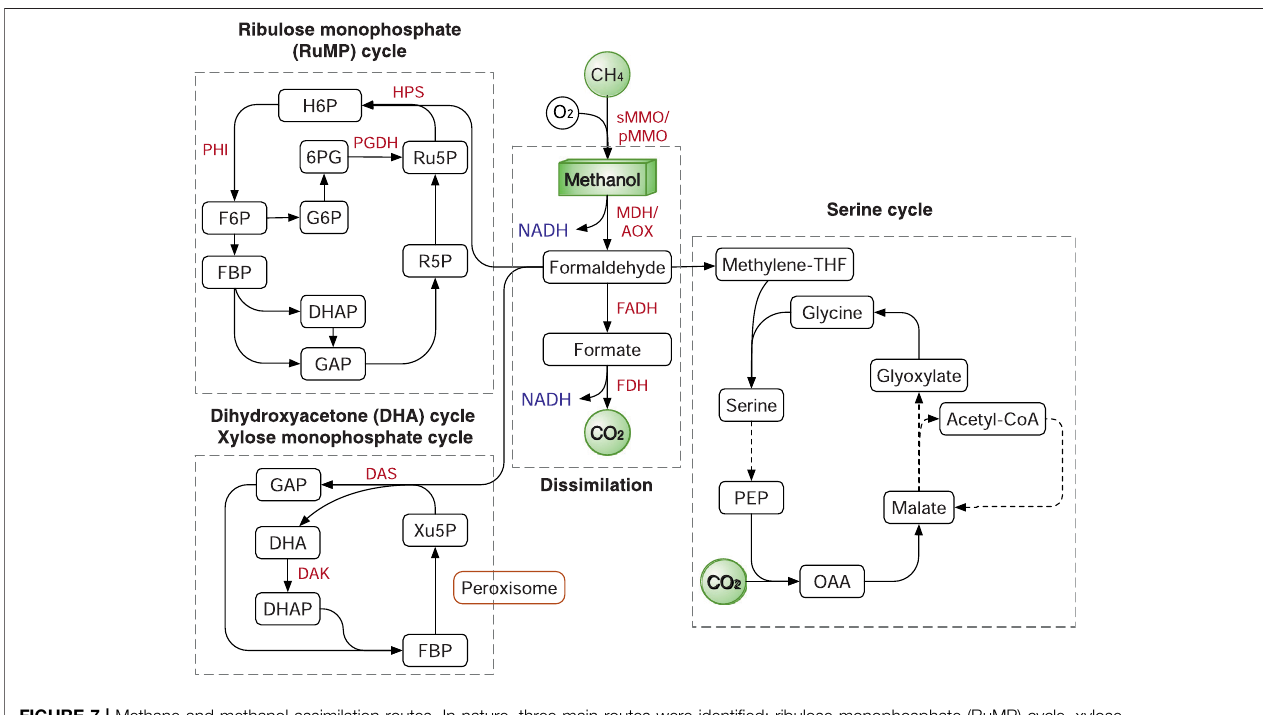
FIGURE 7 | Methane and methanol assimilation routes. In nature, three main routes were identi fi ed: ribulose monophosphate (RuMP) cycle, xylose monophosphate (XuMP) cycle or dihydroxyacetone (DHA) cycle and Serine cycle. Enzymes: HPS, 3-hexulose-6-phosphate synthase; PHI, 6-phosphate-3- hexuloisomerase; PGDH, 6-phosphogluconate dehydrogenase; MMO, methane monooxygenase; MDH, methanol dehydrogenase; AOX, alcohol oxidase; FADH, formaldehyde dehydrogenase; FDH, formate dehydrogenase. Metabolites: H6P, hexulose 6-phosphate; F6P, fructose-6-phosphate; FBP, fructose 1,6- bisphosphatase; G6P, glucose-6-phosphate; 6PG, 6-phosphogluconate; GAP, glyceraldehyde-3-phosphate; DHAP, dihydroxyacetone phosphate; R5P, ribose 5- phosphate; DHA, dihydroxyacetone; Xu5P, xylulose-5-phosphate; PEP, phosphoenolpyruvate; OAA,